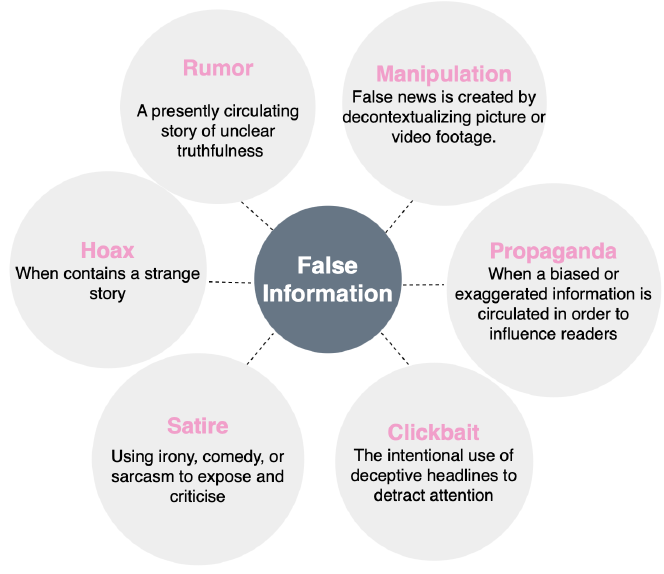
Figure 1. False information